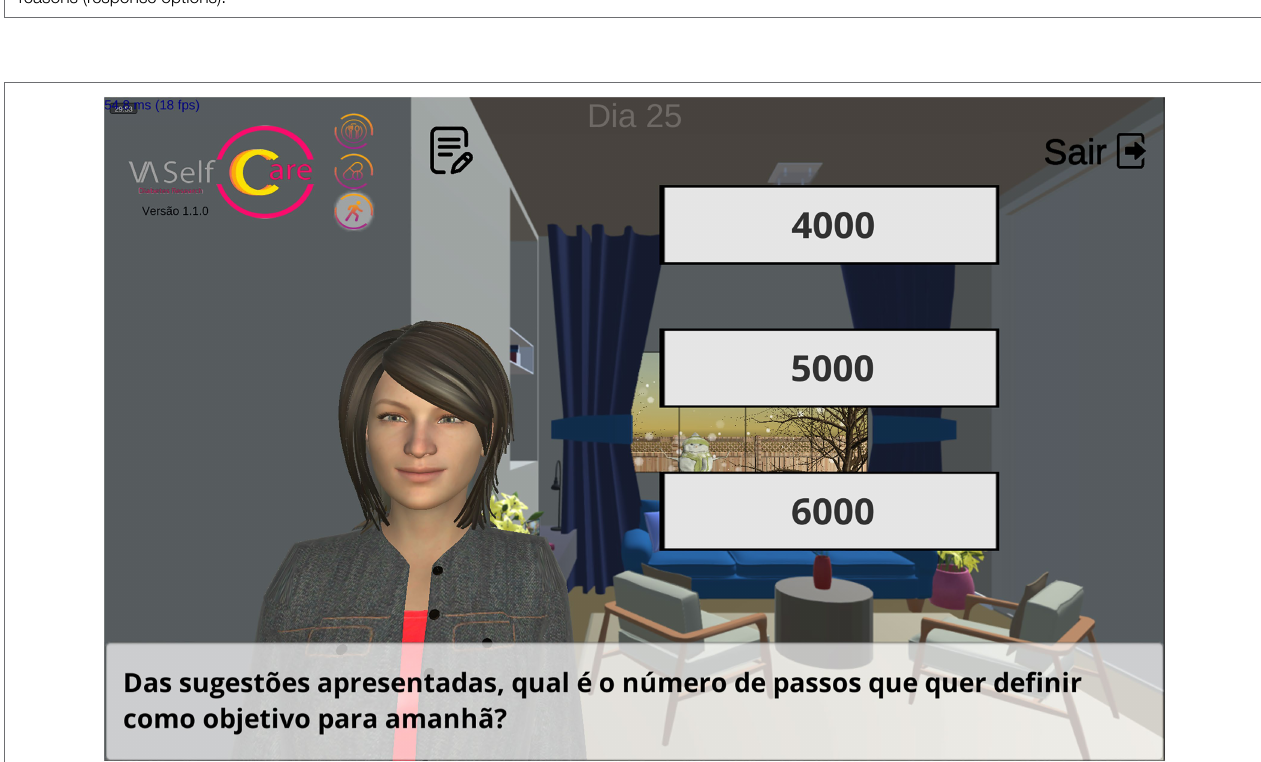
FIGURE 7 | Interface in the mobile application: Vitoria reviewing the number of steps goal (review behavior goal 1.5). Translation to English: Of the suggestions presented, what is the number of steps you want to set as a goal for tomorrow?